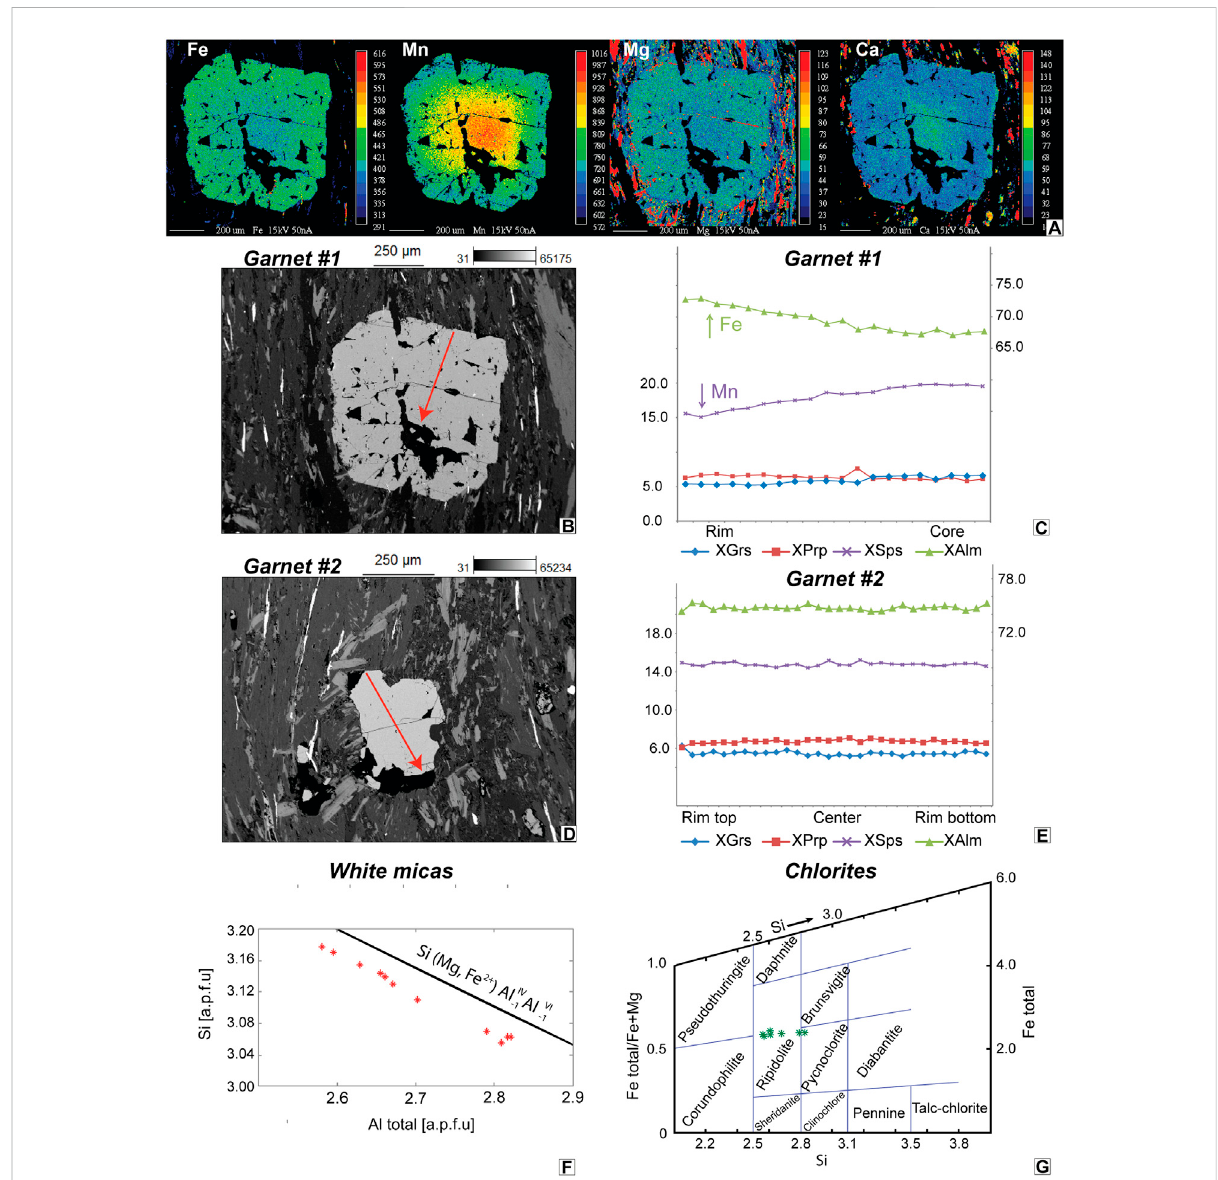
FIGURE 9 (A) Garnet element distributionmaps ofFe, Mn,Mg, Ca concentration,obtained with CAMECASX100.Colourscale refersto counts per second of corresponding K α radiation, where the lowest and the highest concentrations are in blue and red, in that order. (B) SEM image with the analysed linebeyondthegarnet#1porphyroblasts. (C) Chemical pro fi leoftheorangearrowofthePanel (B) . (D) SEM imagewiththeanalysedlinebeyondthe garnet #2 porphyroblasts. (E) Chemical pro fi le of the orange arrowof the Panel (D) . (F) Si – Al variation diagram of white-mica within garnet bearing micaschist (FO1710), the line of the ideal Tschermak substitution is inserted. (G) Si vs. XFe Chlorite classi fi cation diagram of Hey (1954), the green asterisk corresponds to chlorite of the FO1710